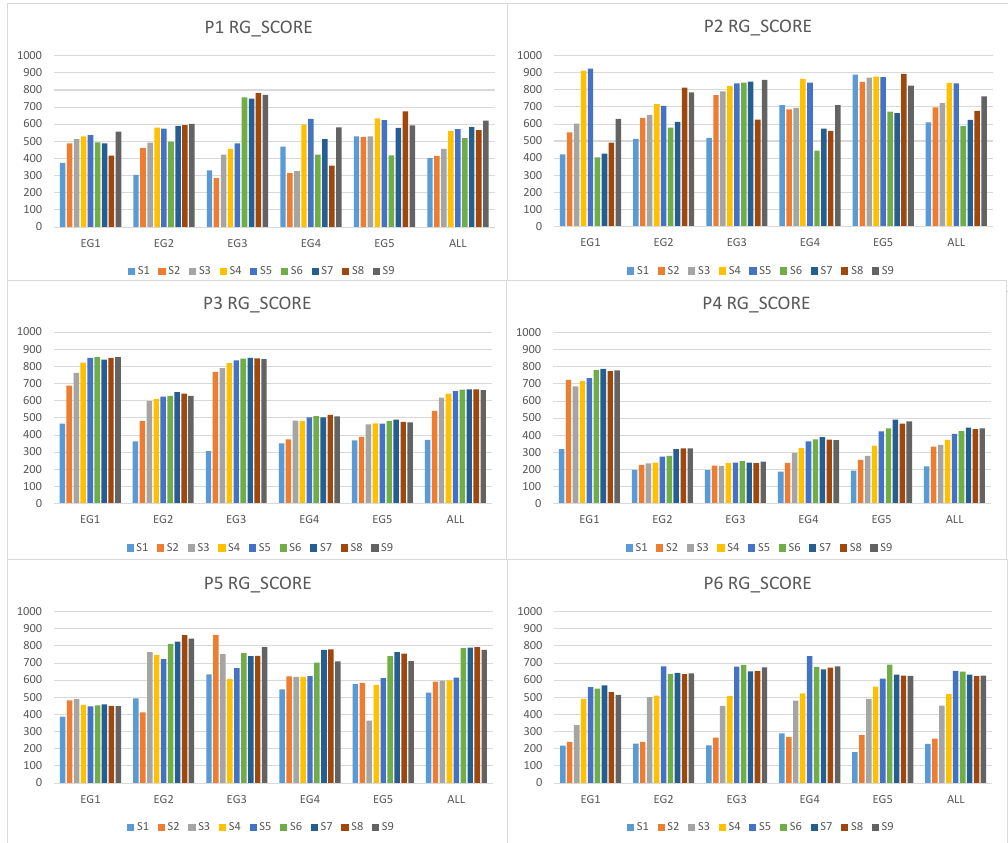
Figure 3. The graphs show the RG_SCORE obtained by each participant (P1, P2, P3, P4, P5, P6) during 5 exergames (EG1, EG2, EG3, EG4, EG5, ALL) and 9 sessions (S1, S2, S3, S4, S5, S6, S7, S8, S9) with the RG module. Table 3. T and p -value from the t -test for RG_SCORE. Signicance levels: * for p < 0.05, *** for p < 0.001